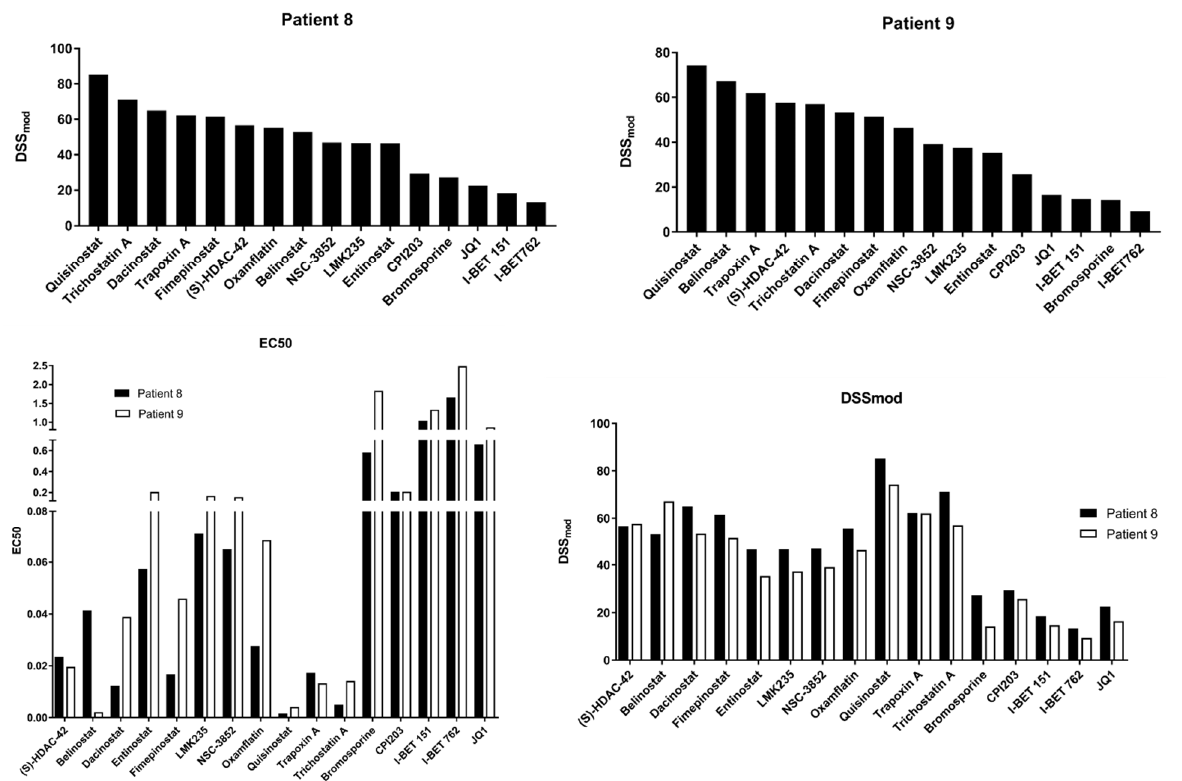
Figure 2. EC 50 and drug sensitivity scoring for 16 select compounds in two patient-derived cell lines. Table 3. Efficacious epigenetic compounds in clinical evaluation for